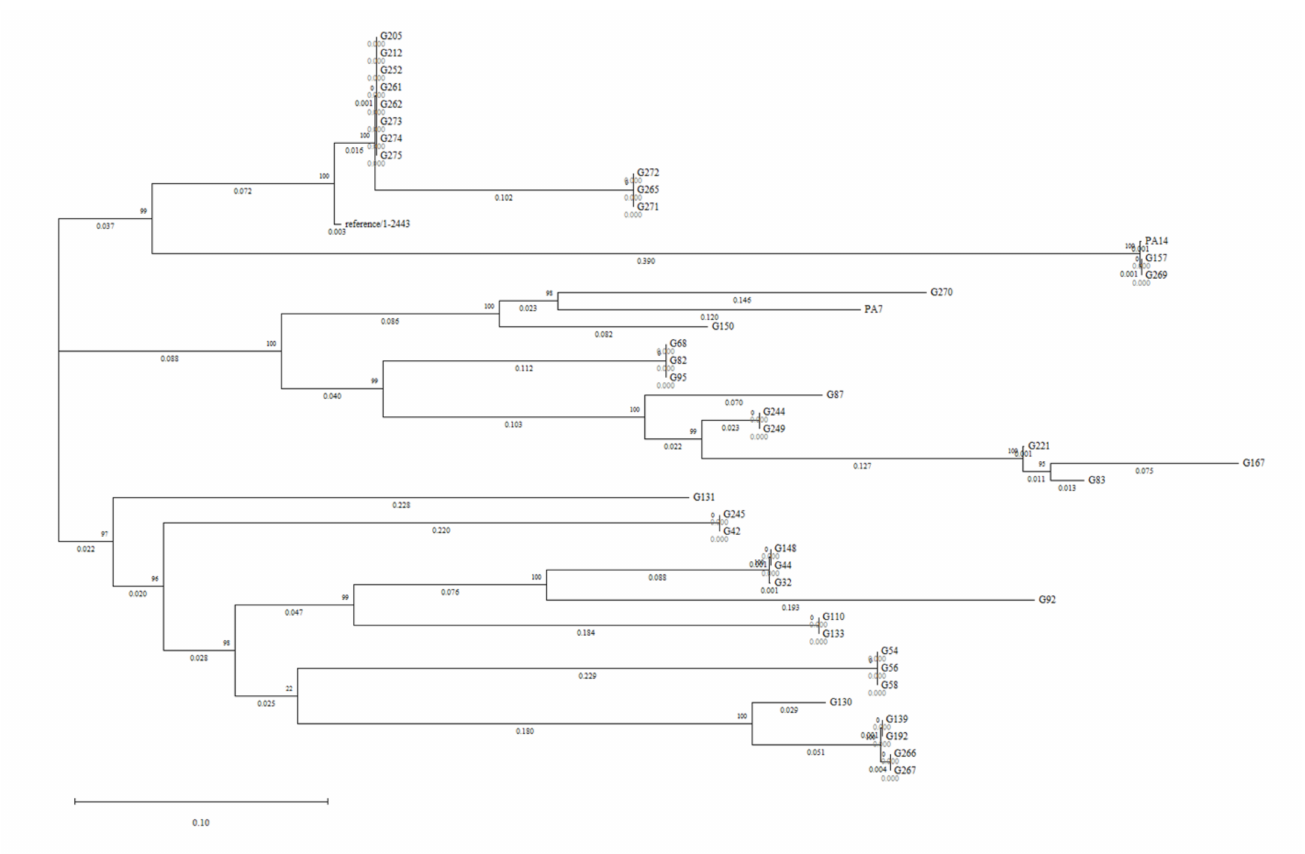
Figure 3. Phylogenetic tree of the crpP -ICEs detected in the 43 crpP -positive P. aeruginosa and the reference plasmid pUM505 (reference 1-2443) build based on the concatenated alignment of